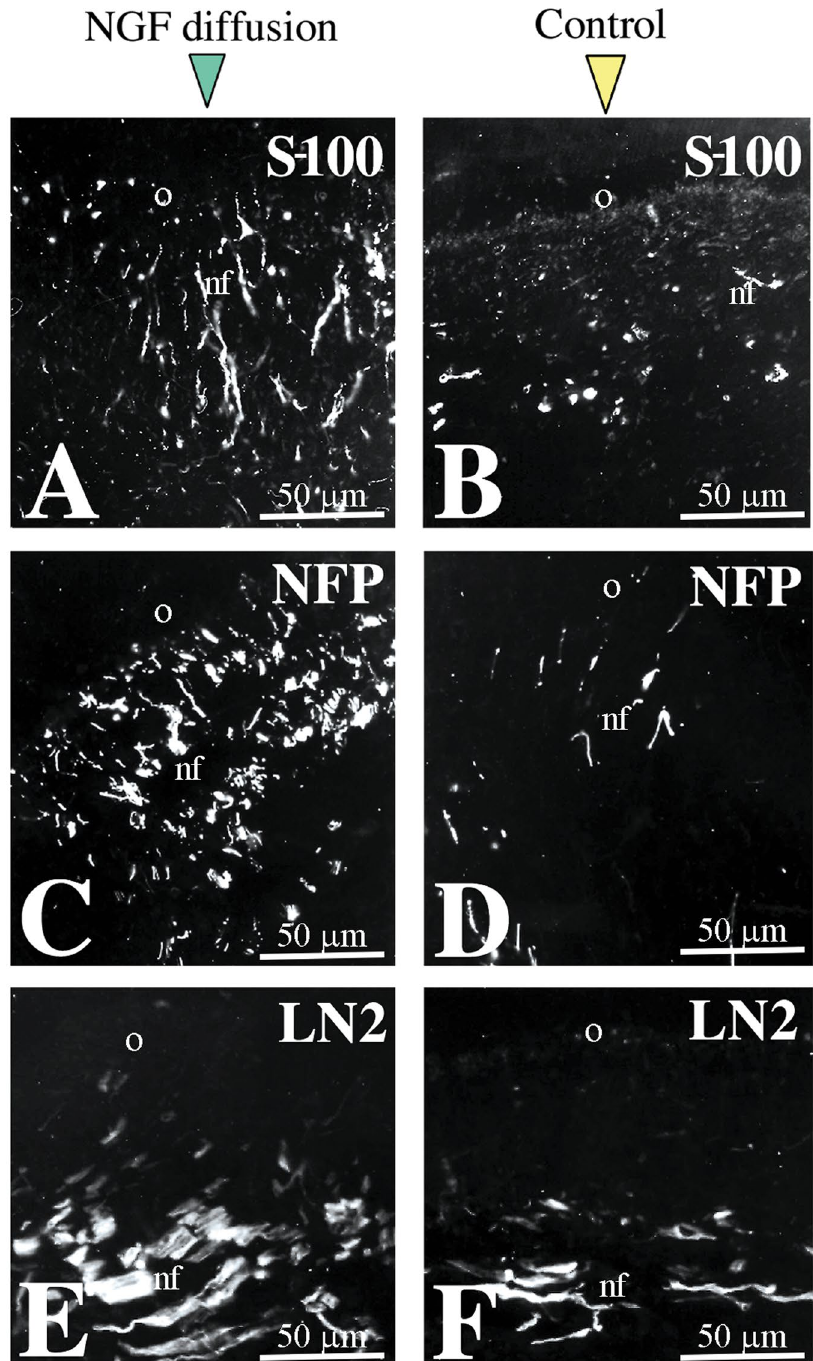
Figure 8. NGF administration induces growth of axons and migration of glial cells. ( A , B ) S-100 staining marking glial cells in NGF-treated ( A ) and control ( B ) pulps. ( C , D ) Neurofilament (NFP) staining marking axons in NGF-treated ( C ) and control ( D ) pulps. ( E , F ) Laminin- α 2 (LN2) expression in NGF-treated ( E ) and control ( F ) pulps. Abbreviations: nf, nerve fibres; o,